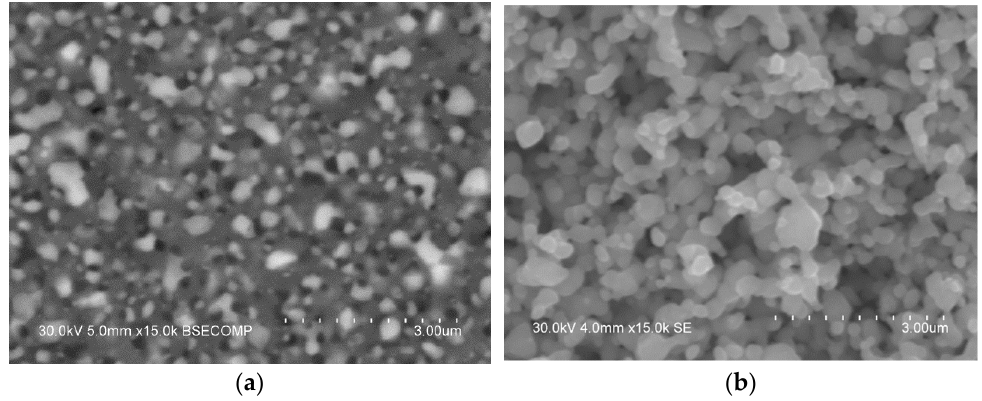
Figure 12. Microstructure (BSE image) of the Fe-Ag pseudo-alloy obtained by SPS of the HEBM powder ( a ), morphology (SE image) of porous silver obtained by selective dissolution of iron from the sintered Fe-Ag pseudo-alloy ( b ). Reprinted from [53], Copyright (2022), with permission from Elsevier.